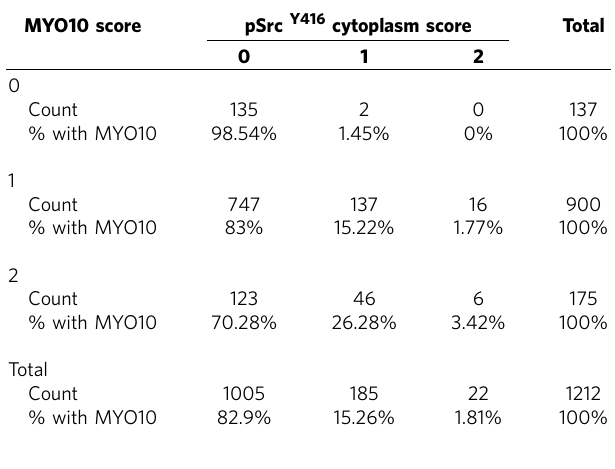
Table 1 | MYO10 staining and pSrc Y416 cytoplasm staining in FinProg